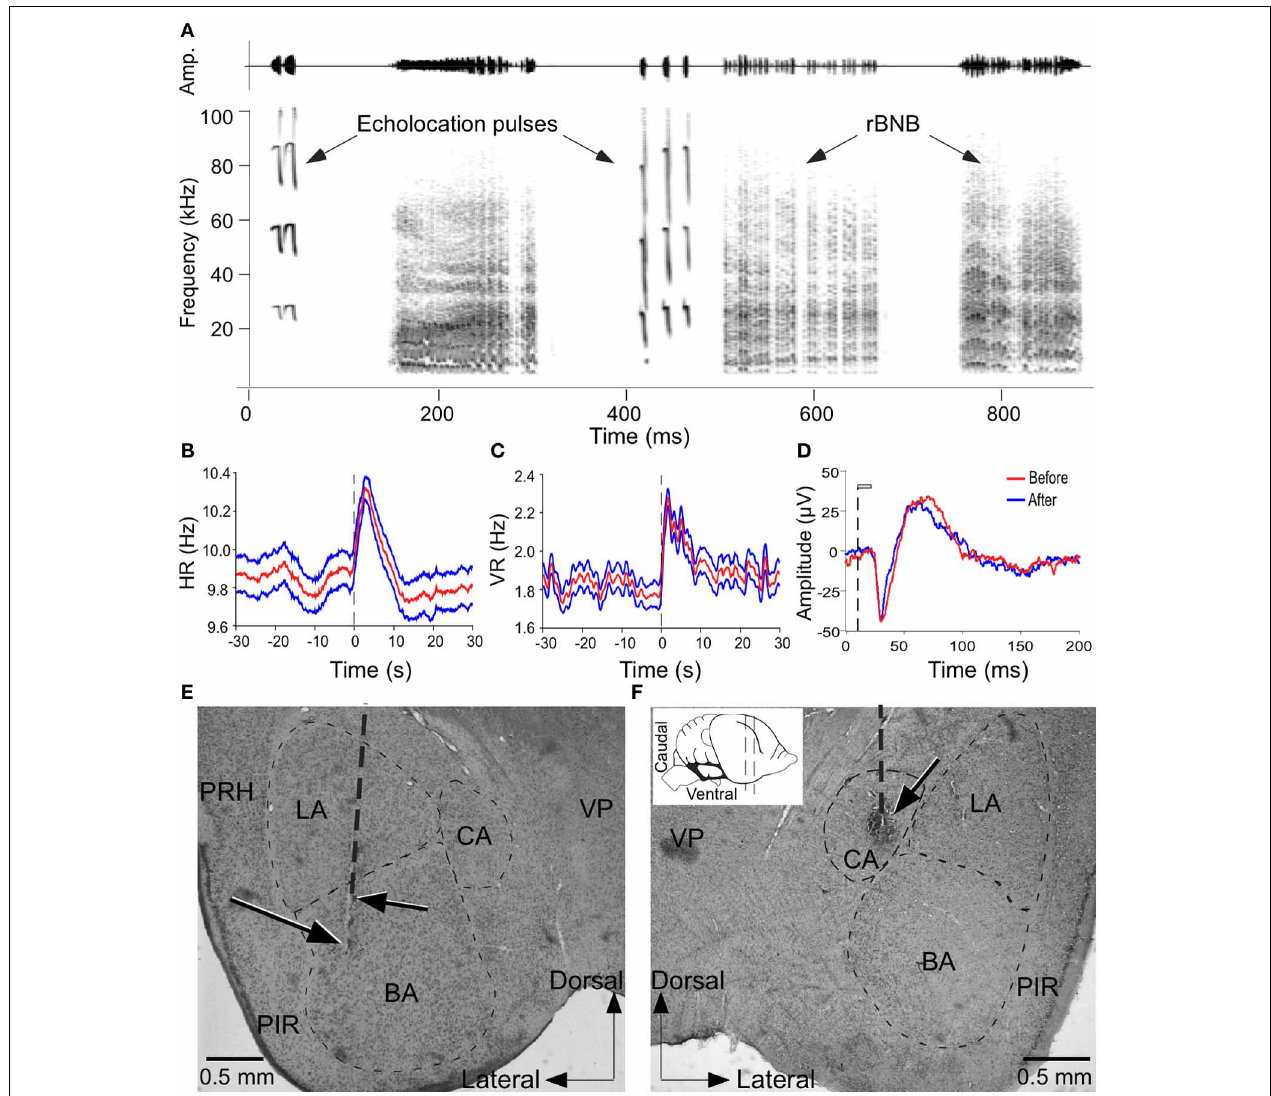
FIGURE 1 | Microstimulation of the amygdala elicited changes in autonomic and vocal activity. (A) Amplitude envelopes (above) and spectrograms (below) of a sequence of echolocation and social vocalizations after electrical stimulation of the amygdala. (B,C) Plots to show increase in HR (B) and VR (C) before, during and after stimulation of a site in the amygdala. Both HR and VR continue to increase after stimulation and decline gradually returning to normal in 10–12s. Vertical dashed line indicates stimulus onset at time 0. Red trace in middle (mean) is flanked by values for ± 1 standard deviation of the mean. (D) LFP traces to show the integrity of neurons at a stimulation site based on the similarity in the shape and peaks in the